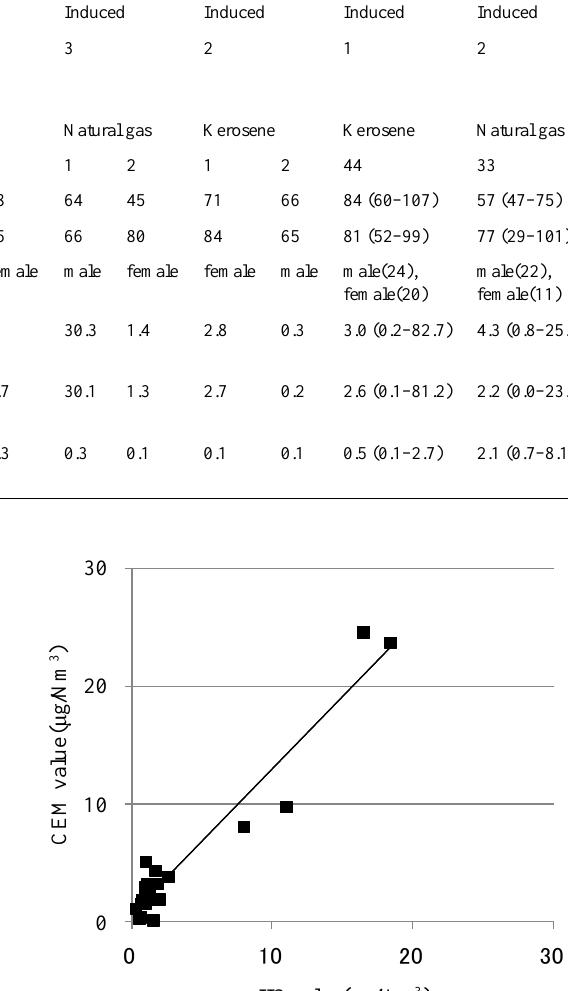
CEM = 1 . 23 ( JIS ) + 0 . 687 (R 2 = 0 . 93 ), (1) where CEM = CEM value (µg/Nm 3 ) ; JIS = JIS value (µg/Nm 3 ) . Although the CEM values were slightly higher than the JIS values, the correlation coefficient was considered to be sufficiently high to determine trends in mercury